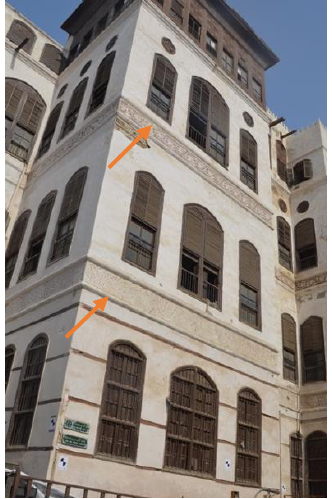
Figure 13. The plaster decoration on the façade of Nasif